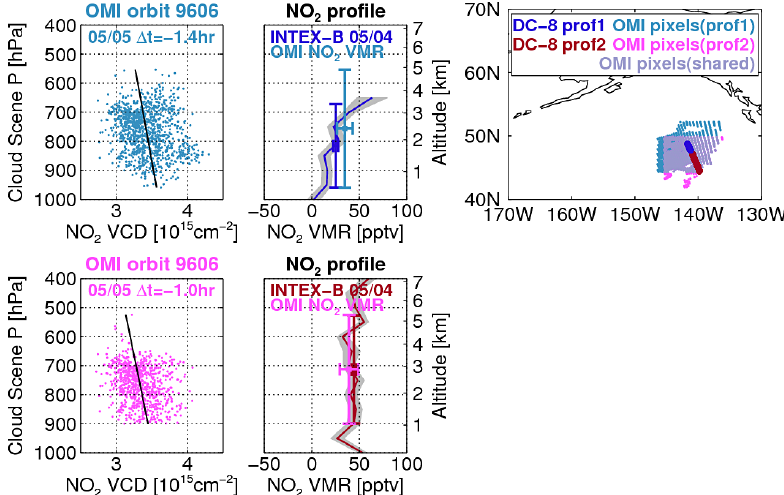
Figure B2. Similar to Fig. B1, showing another example over the northeastern Pacific with a discrepancy between satellite and aircraft data apparently due to small-scale spatial variations in the INTEX-B NO 2